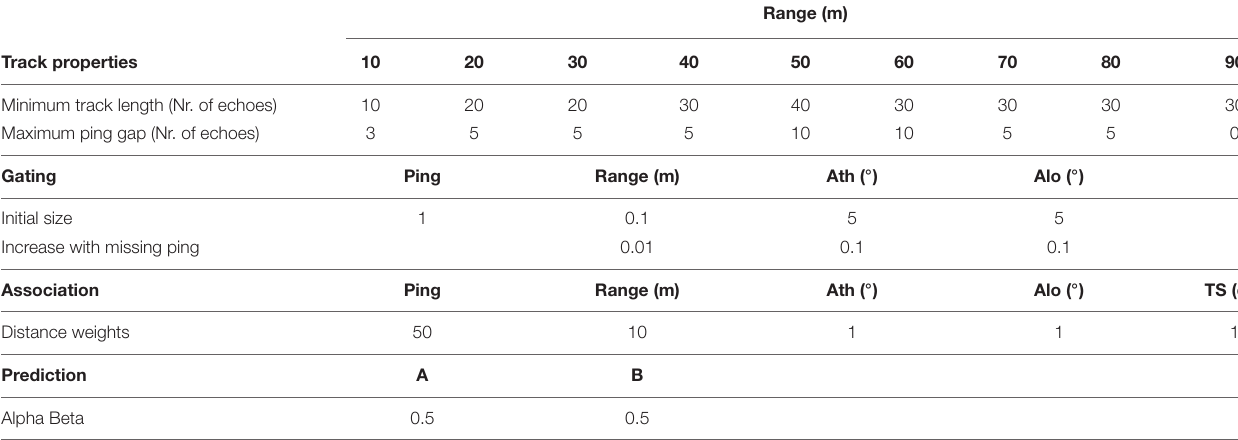
TABLE 1 | Settings used in the automatic target tracking analysis in Sonar5-Pro (Balk and Lindem, 2017).